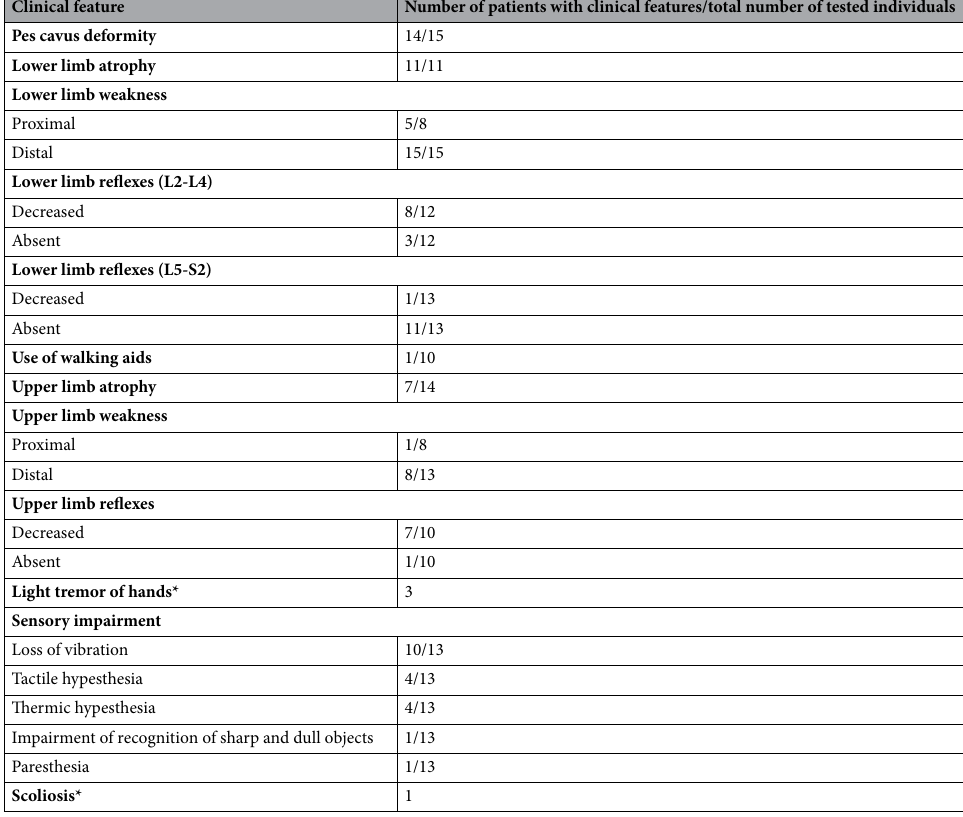
Table 3. A summary of the clinical features of patients with biallelic pathogenic variants in the SORD gene. Total individuals tested = 18. In total, 18 patients were included. The number of patients with a particular clinical sign are shown in the second column. The total number of patients tested for a particular sign is shown after the forward slash. For some of the patients, the information was not available. For some clinical signs - marked with *- only the number of patients with positive signs is given.